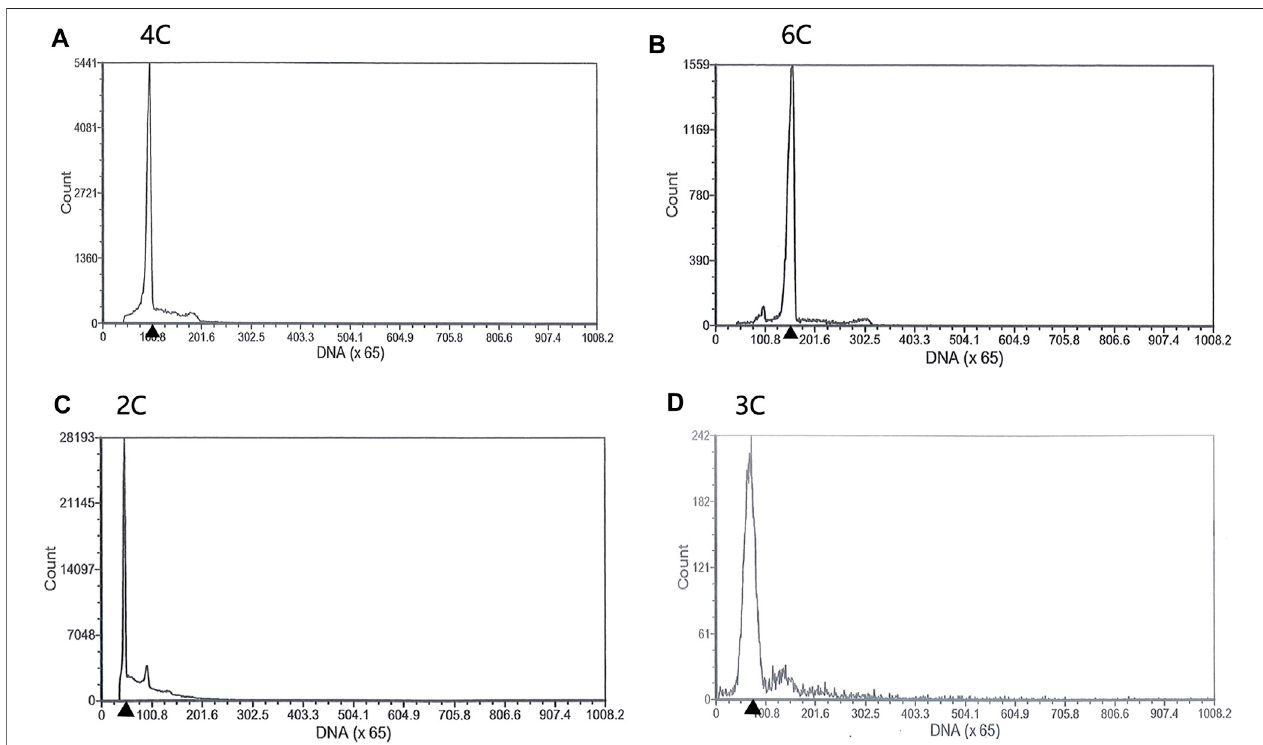
FIGURE 1 | Flow cytometry histograms of semen cells obtained from 2nDTCC and 3nDTCC. The blood cells of 2nDTCC and 3nDTCC were detected as the control. (A) Blood cells of2nDTCC (DNA content, 4C). (B) Blood cells of 3nDTCC (DNA content, 6C). (C) Semen cells of2nDTCC (DNA content, 2C). (D) Semencells of 3nDTCC (DNA content,